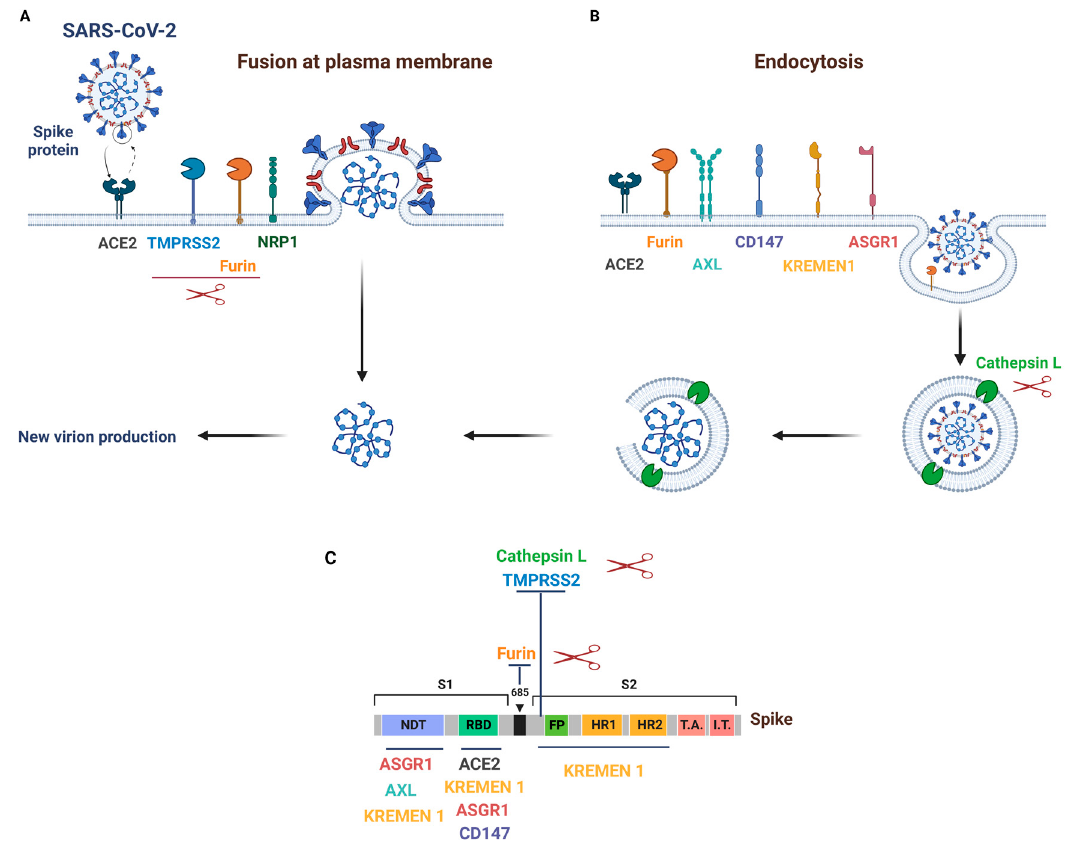
Figure 2. Main receptors and cofactors of SARS-CoV-2, adapted from [24]. Viral entry relies on two mechanisms: ( A ) fusion of the virus with the plasma membrane, mechanism ACE2 and TMPRSS2 dependent, ( B ) entry of the virus by endocytosis, mechanism TMPRSS2 independent and involving cathepsin L. Entry by endocytosis depends on binding to ACE2 or ACE2-independent receptors AXL, CD147, KREMEN1 and/or ASGR1. ( C ) Mapping of the binding sites of SARS-CoV-2 receptors on the spike protein.